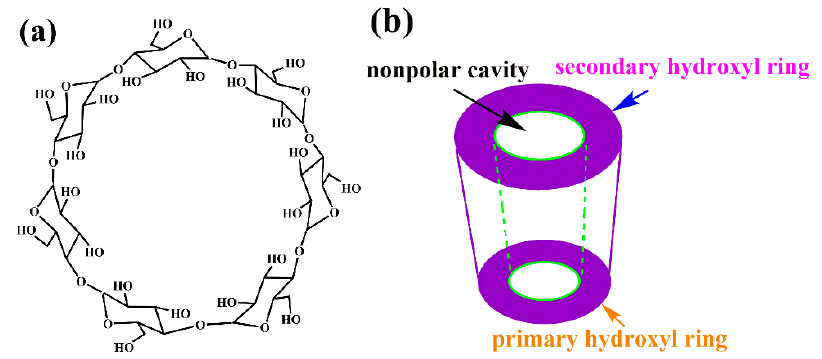
Figure 1. Molecular structure ( a ) and molecular shape ( b ) of β -CD.